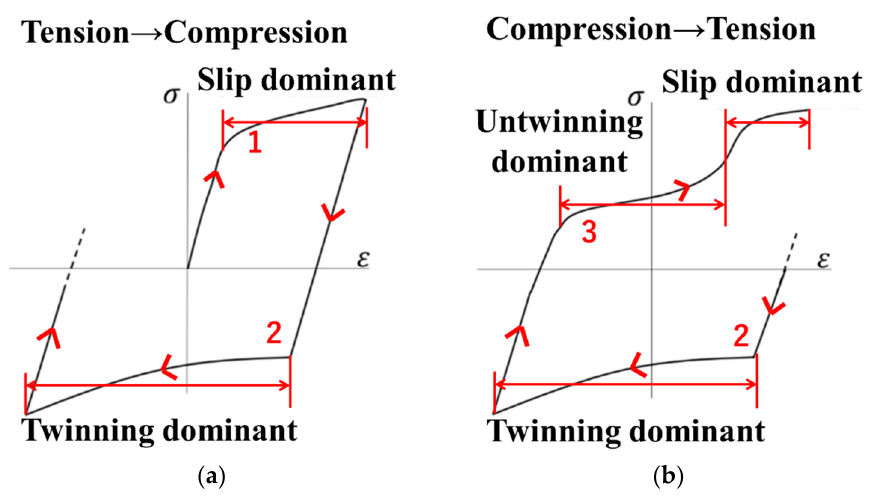
Figure 1. Asymmetry of stress-strain curves: ( a ) tension to compression; ( b ) compression to ten- sion.